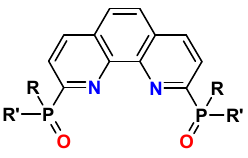
Figure 15. 2,2′-bipyridyl-6,6′-diphosphine oxides ( BDPO ).